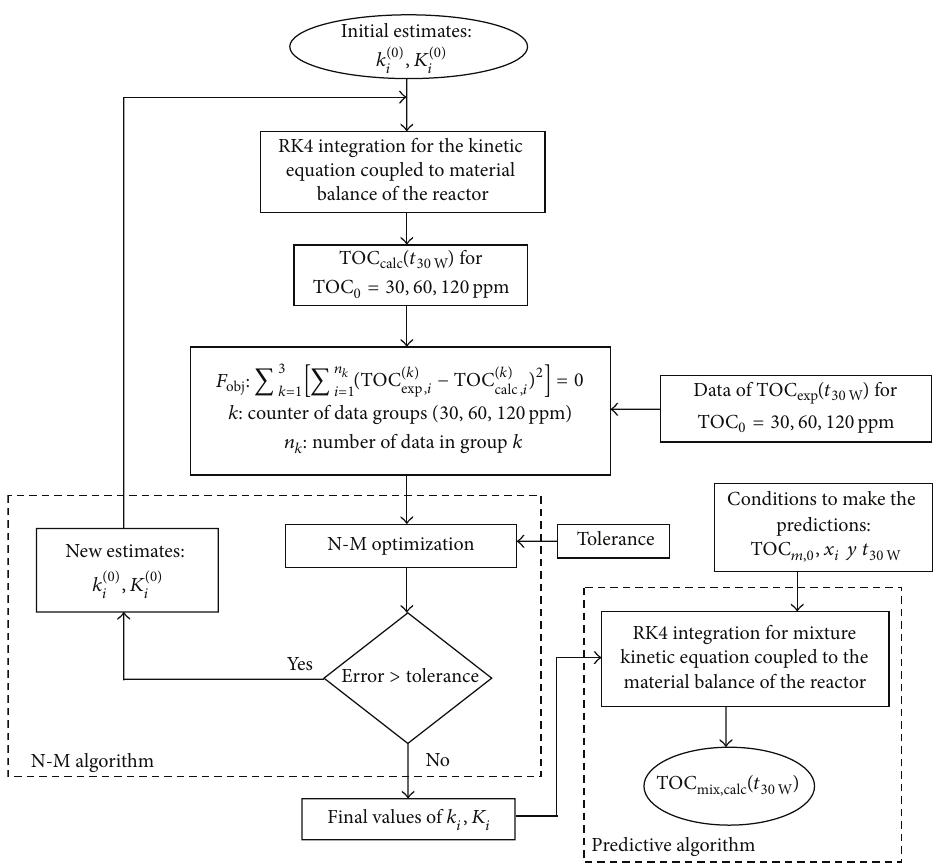
Figure 1: Algorithms of fitting of kinetic parameters and prediction by mixing